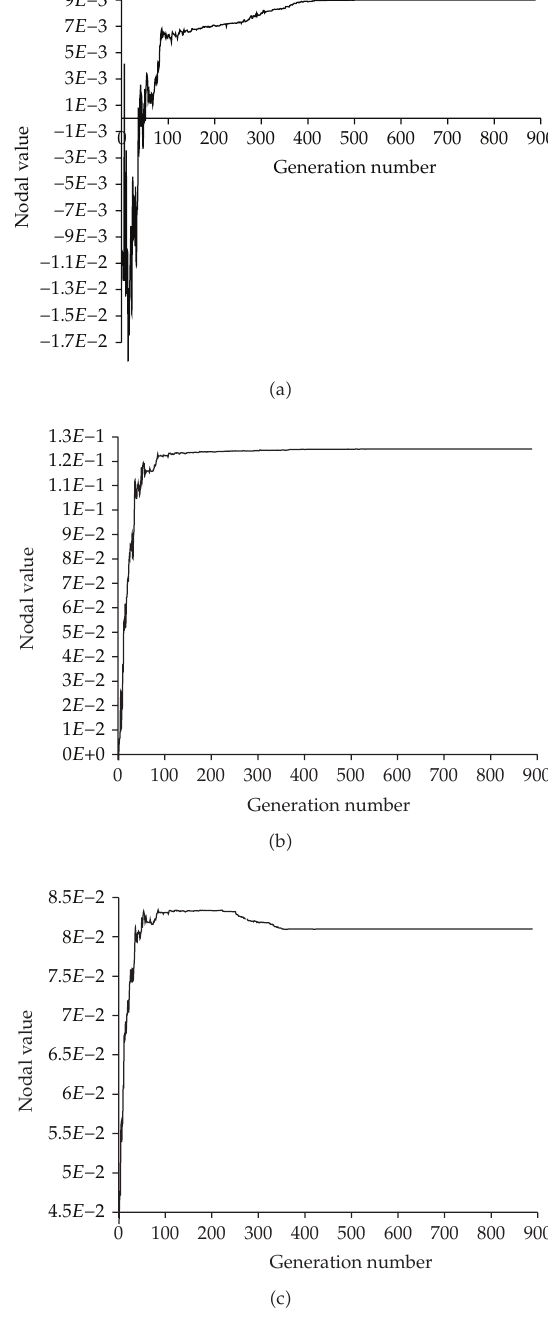
Figure 6: Evolution of the nodal values for Problem 1 of (cid:3) a (cid:4) the first node; (cid:3) b (cid:4) the middle node; (cid:3) c (cid:4) the ninth